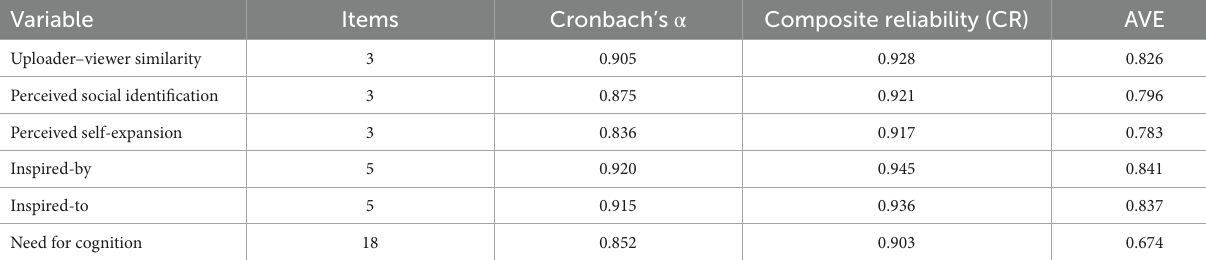
TABLE 2 Results of the confirmatory factor analysis. Variable